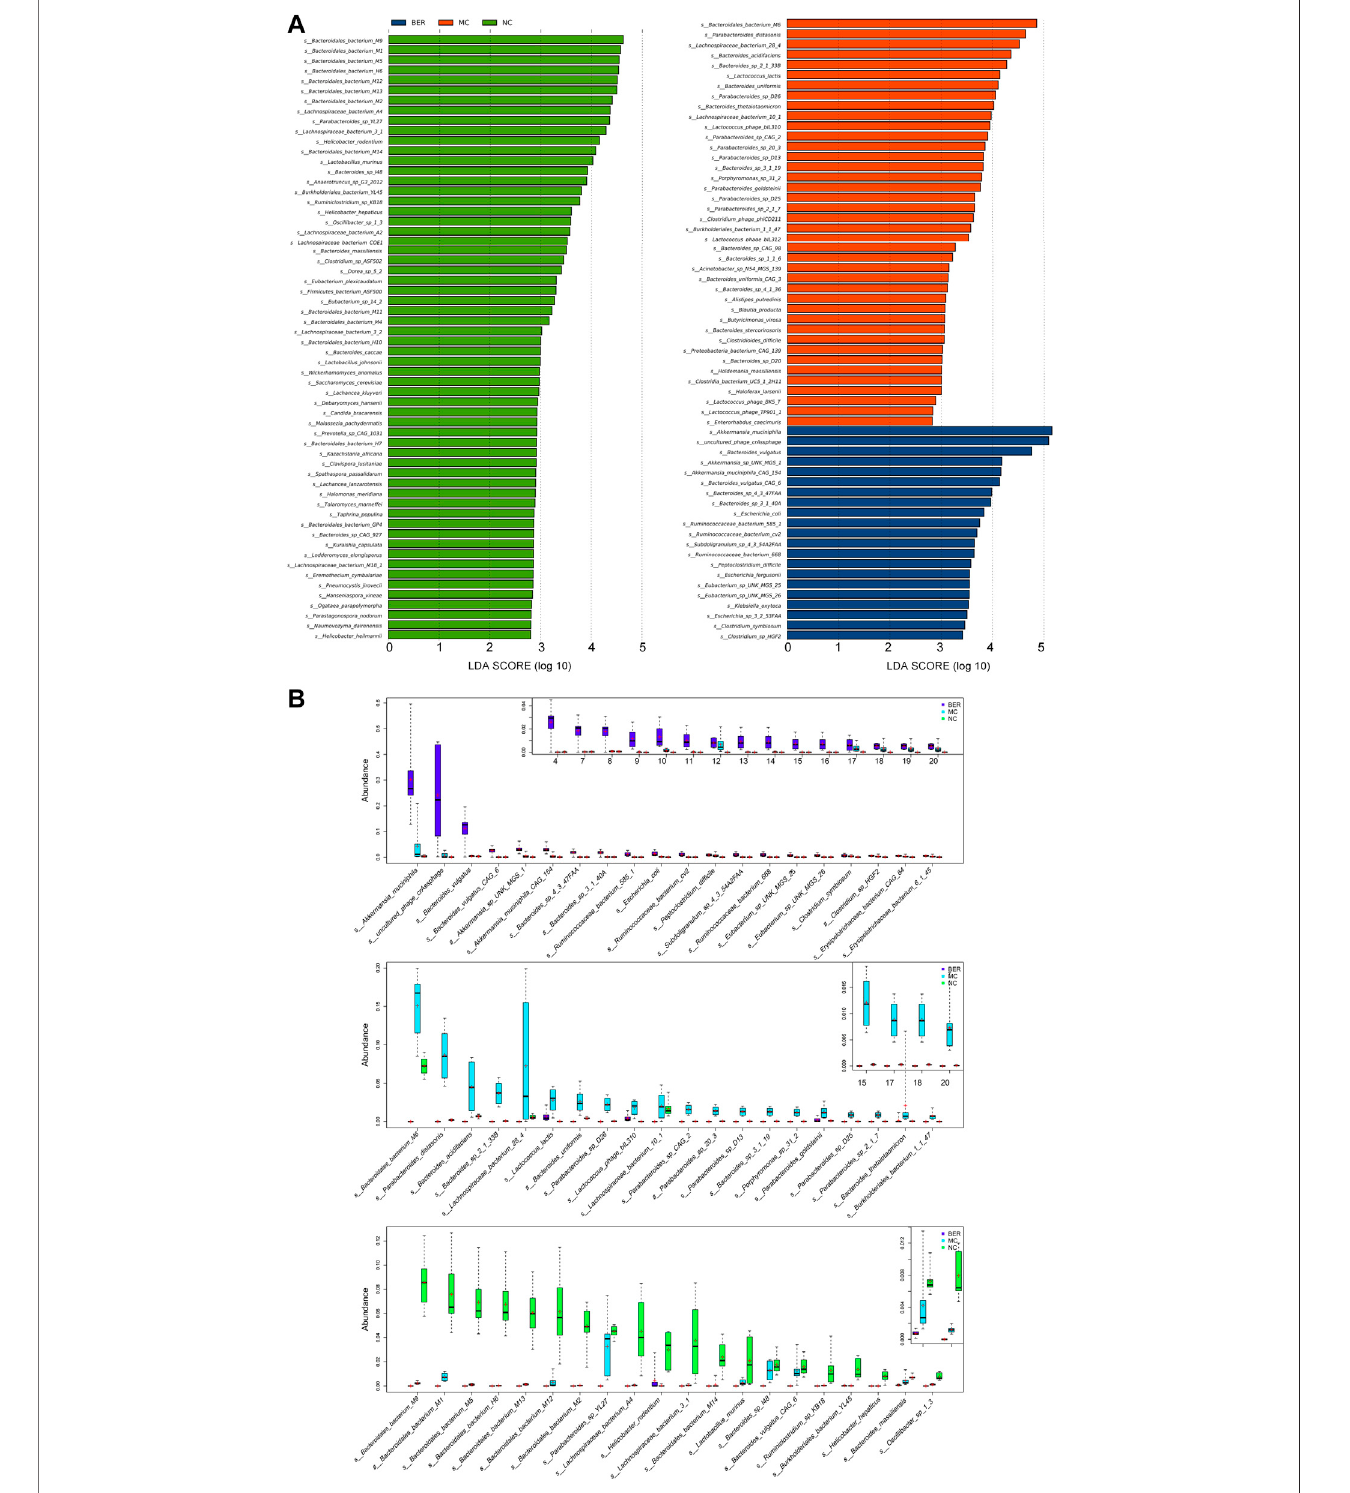
FIGURE3| Abundanceofdifferentialspeciesineachgroup. (A) LEfSedifferentialspeciesplot. (B) Relativeabundanceboxplotofdominantspeciesineachgroup. Boxes represent the interquartile ranges, lines inside the boxes denote medians, and signs indicate mean value.